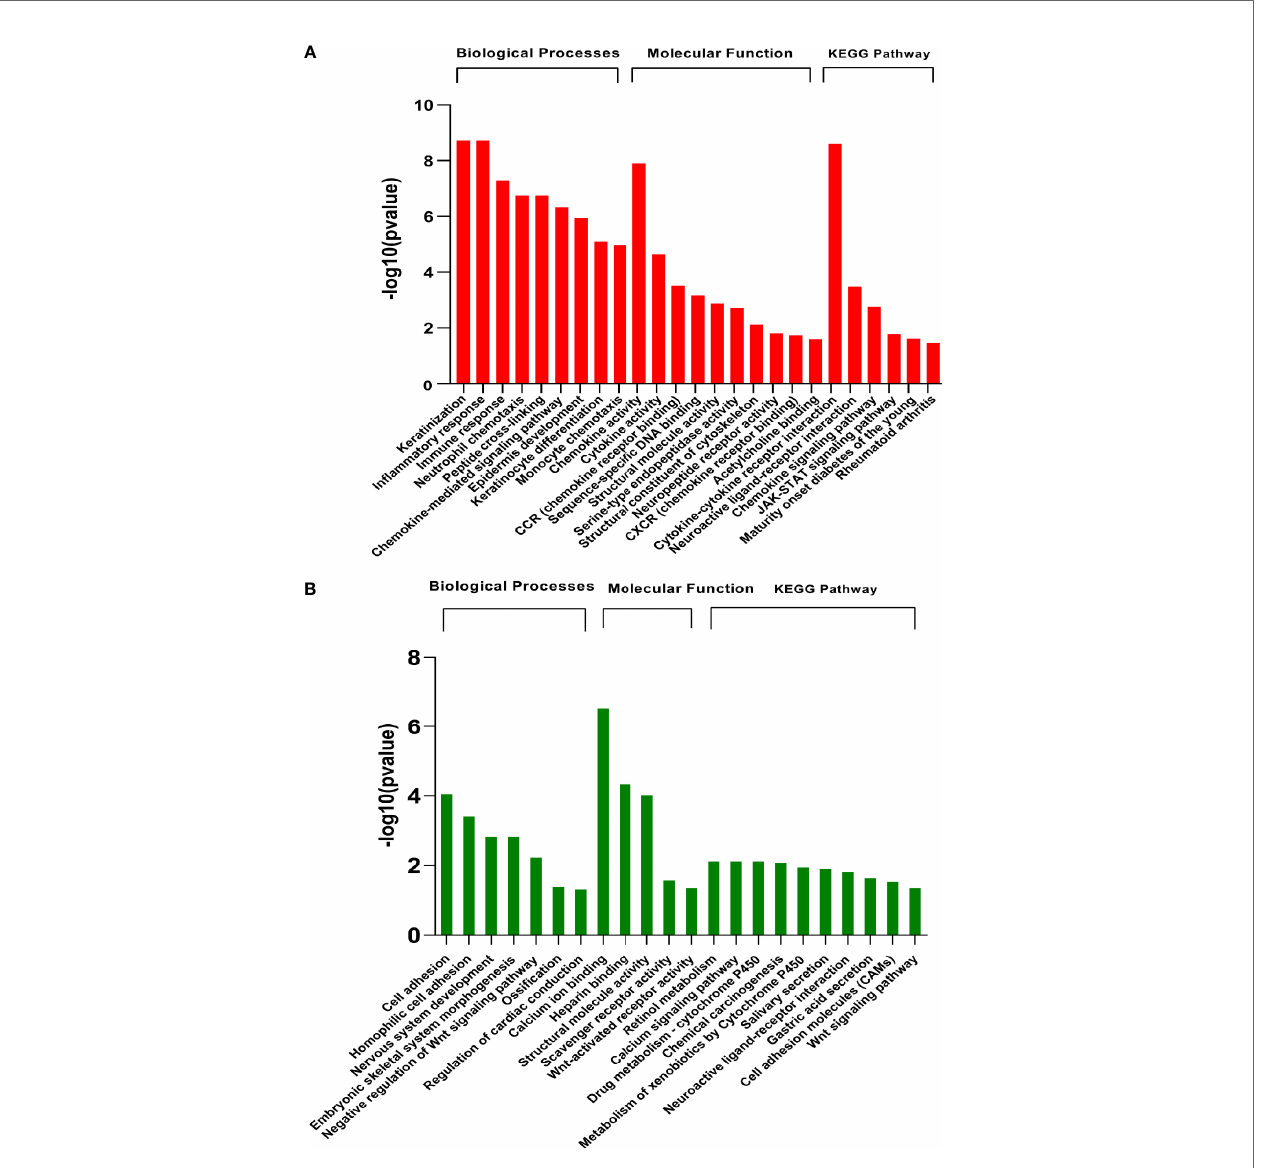
FIGURE 3 | Pathway enrichment analysis of differentially expressed genes (GSE178563). Signi fi cantly (A) upregulated and (B) downregulated pathways (FDR<0.05) enriched in differentially expressed genes using Gene Ontology biological processes, molecular function, and KEGG database by DAVID web